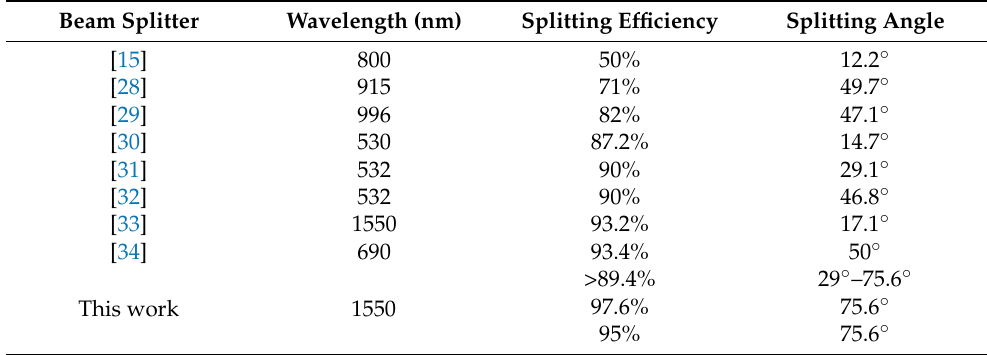
Table 2. Performance comparison of our work to previously reported beam splitters based on